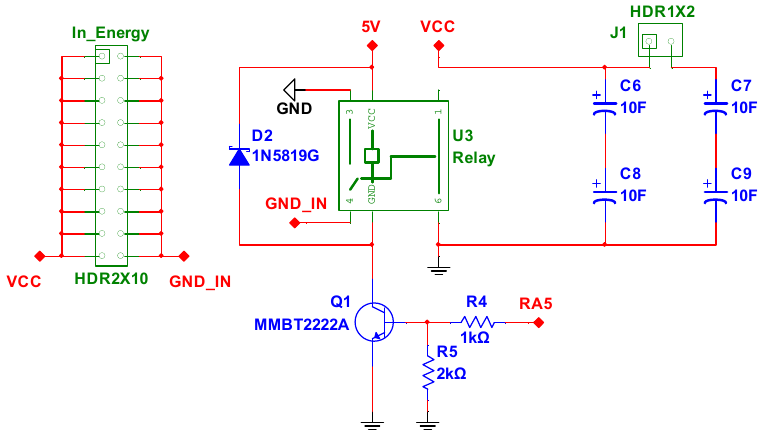
Figure 10. Diagram of the energy storage circuit with its respective relays.